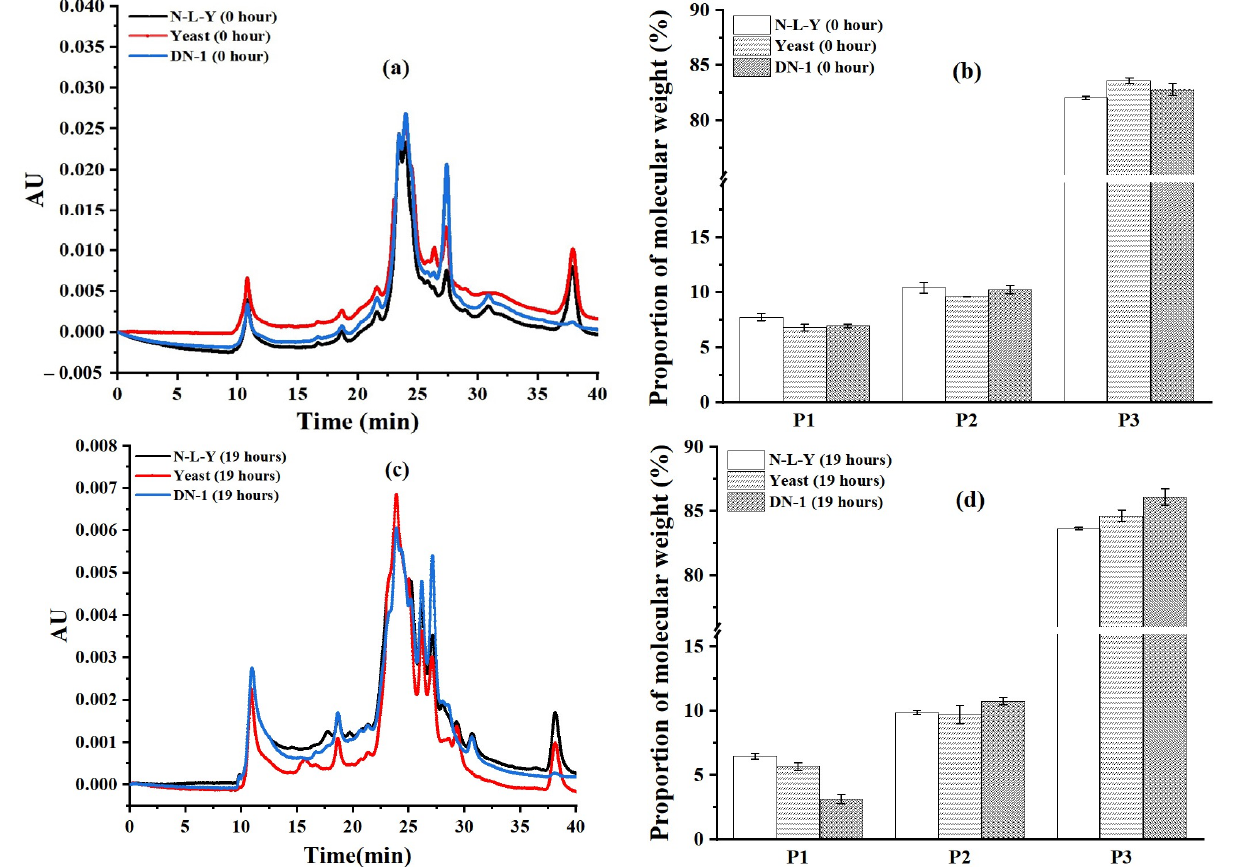
Figure 2. Molecular weight distributions ( a ) and proportion of molecular weights ( b ) of SDS-soluble proteins in the sourdough after fermentation for 0 h. Molecular weight distributions ( c ) and proportion of molecular weights ( d ) of SDS-soluble proteins in the sourdough after fermentation for 19 h. P1 (large glutenin polymers with Mw larger than 91 kDa); P2 (large monomers with Mw from 10 kDa to 91 kDa); and P3 (peptides and amino acids with Mw under 10 kDa). N-L-Y: The dough without yeast and LP HLJ29L2 co-fermentation; yeast: the dough with yeast fermentation alone; DN-1: the sourdough with LP HLJ29L2 and yeast co-fermentation.